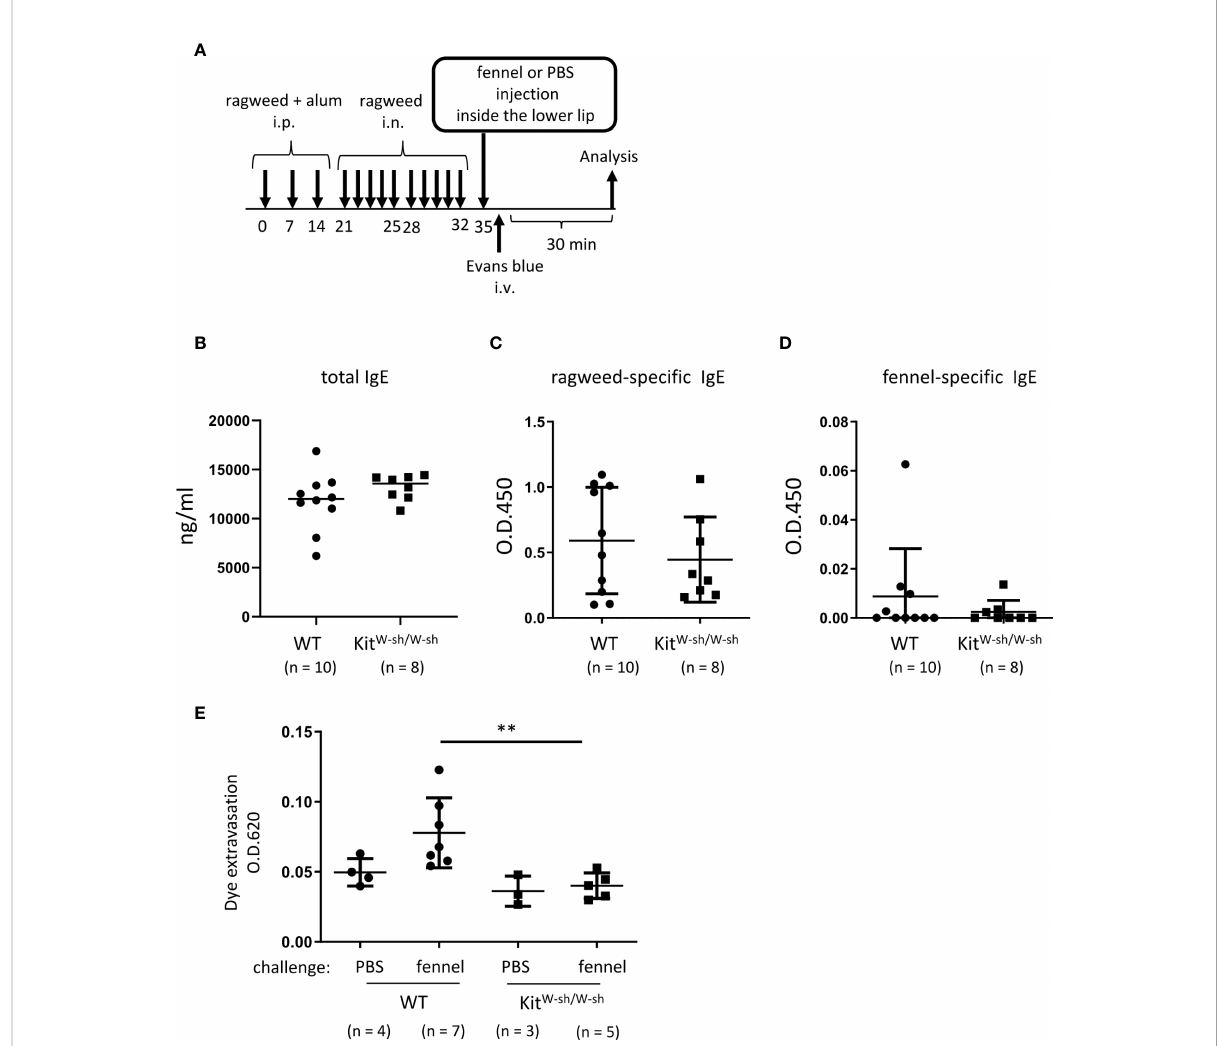
FIGURE 7 Stimulation with fennel extracts induced mast cell-dependent OAS in mice intraperitoneally and intranasally sensitized with ragweed pollen. (A) A schematic representation of murine model of OAS. WT or Kit W-sh / W-sh mice intraperitoneally and intranasally sensitized with ragweed pollen before stimulation with fennel or PBS as a control. (B-D) Serum levels of total IgE (B) , ragweed-speci fi c IgE (C) , or fennel-speci fi c IgE (D) from WT (n = 10) or Kit W-sh / W-sh (n = 8) mice at day 35. (E) Quanti fi cation of the Evans blue dye that extravasated into the neck skin from ragweed- sensitized WT mice stimulated by fennel extracts (n = 7) or PBS (n = 4) or from Kit W-sh / W-sh mice stimulated by fennel extracts (n = 5) or PBS (n = 3). Data are expressed as mean ± SD. Data are representative of two independent experiments. (B-D) Welch ’ s t -test. (E) Brown-Forsythe and Welch ANOVA with Dunnett T3 multiple comparisons. ** P <